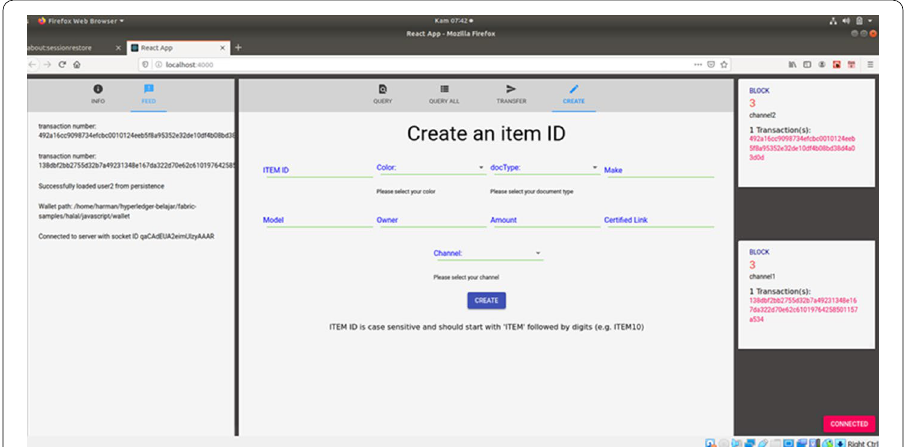
Fig. 4 Display of Blockchain Network’s Web